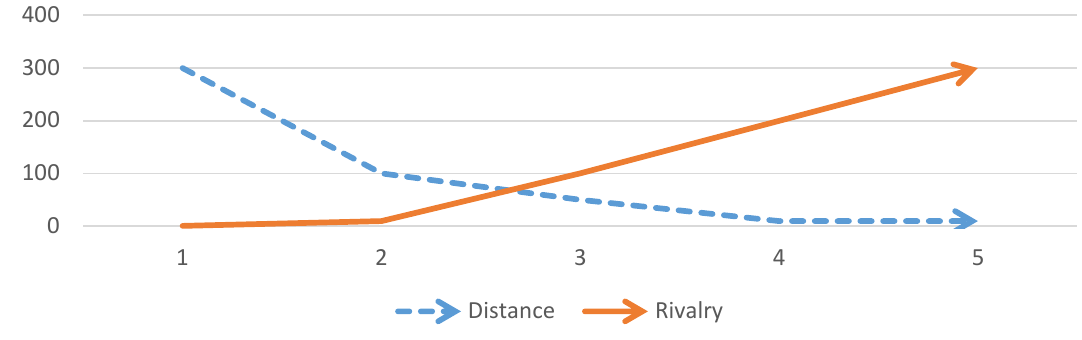
Figure 3. The relationship between distance and rivalry in external or internal